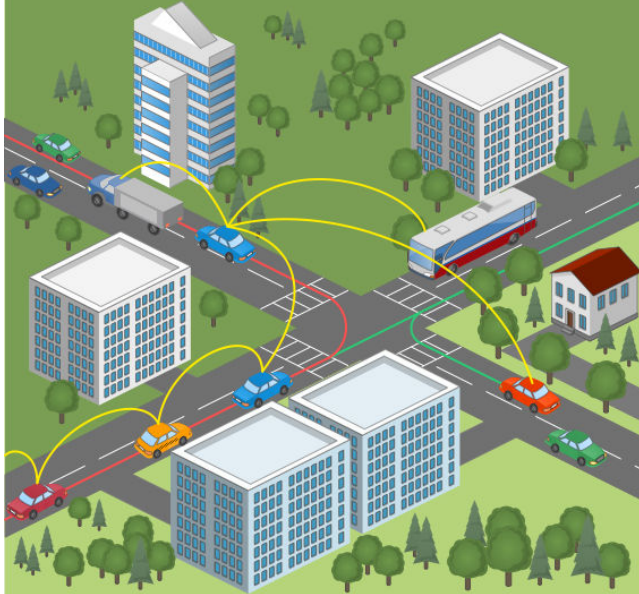
Figure 1. Example of a vehicular ad hoc network (VANET) scenario: accident-information dissemination using vehicle-to-vehicle (V2V) and vehicle-to-infrastructure (V2I) to send data to emergencies